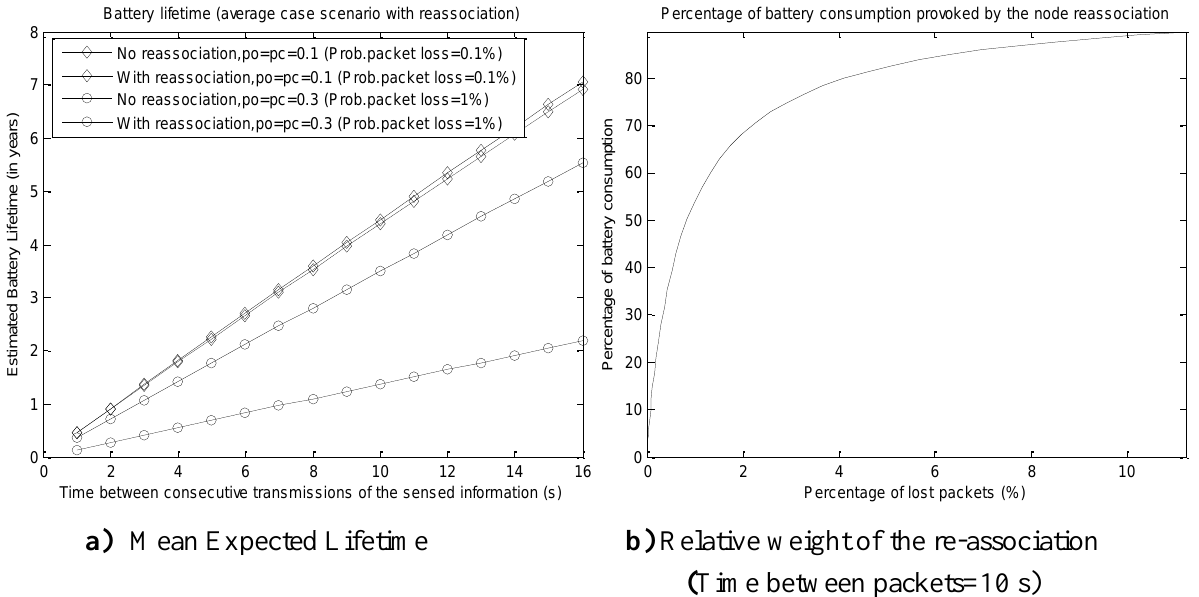
Figure 11. Effect of the re-association on the average battery consumption (Packet size = 2